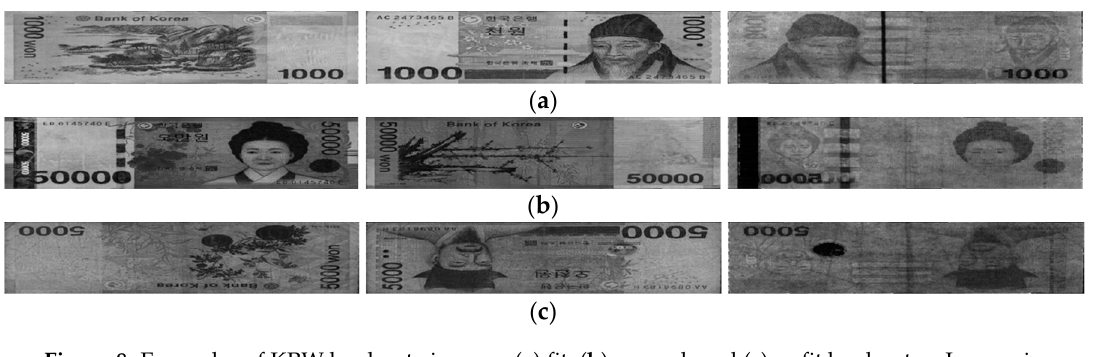
Figure 8. Examples of KRW banknote images: ( a ) fit; ( b ) normal; and ( c ) unfit banknotes. Images in each figure have the same order as those in Figure 7. Table 7. Number of input banknotes in the experimental multinational banknote fitness